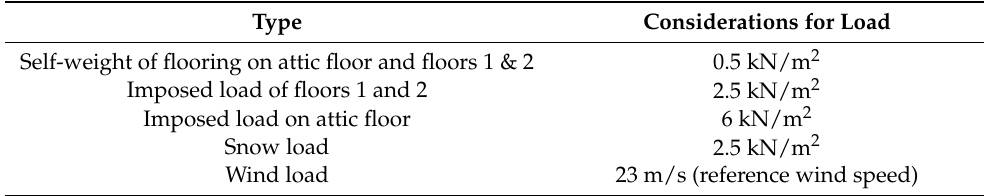
Table 5. Loads of